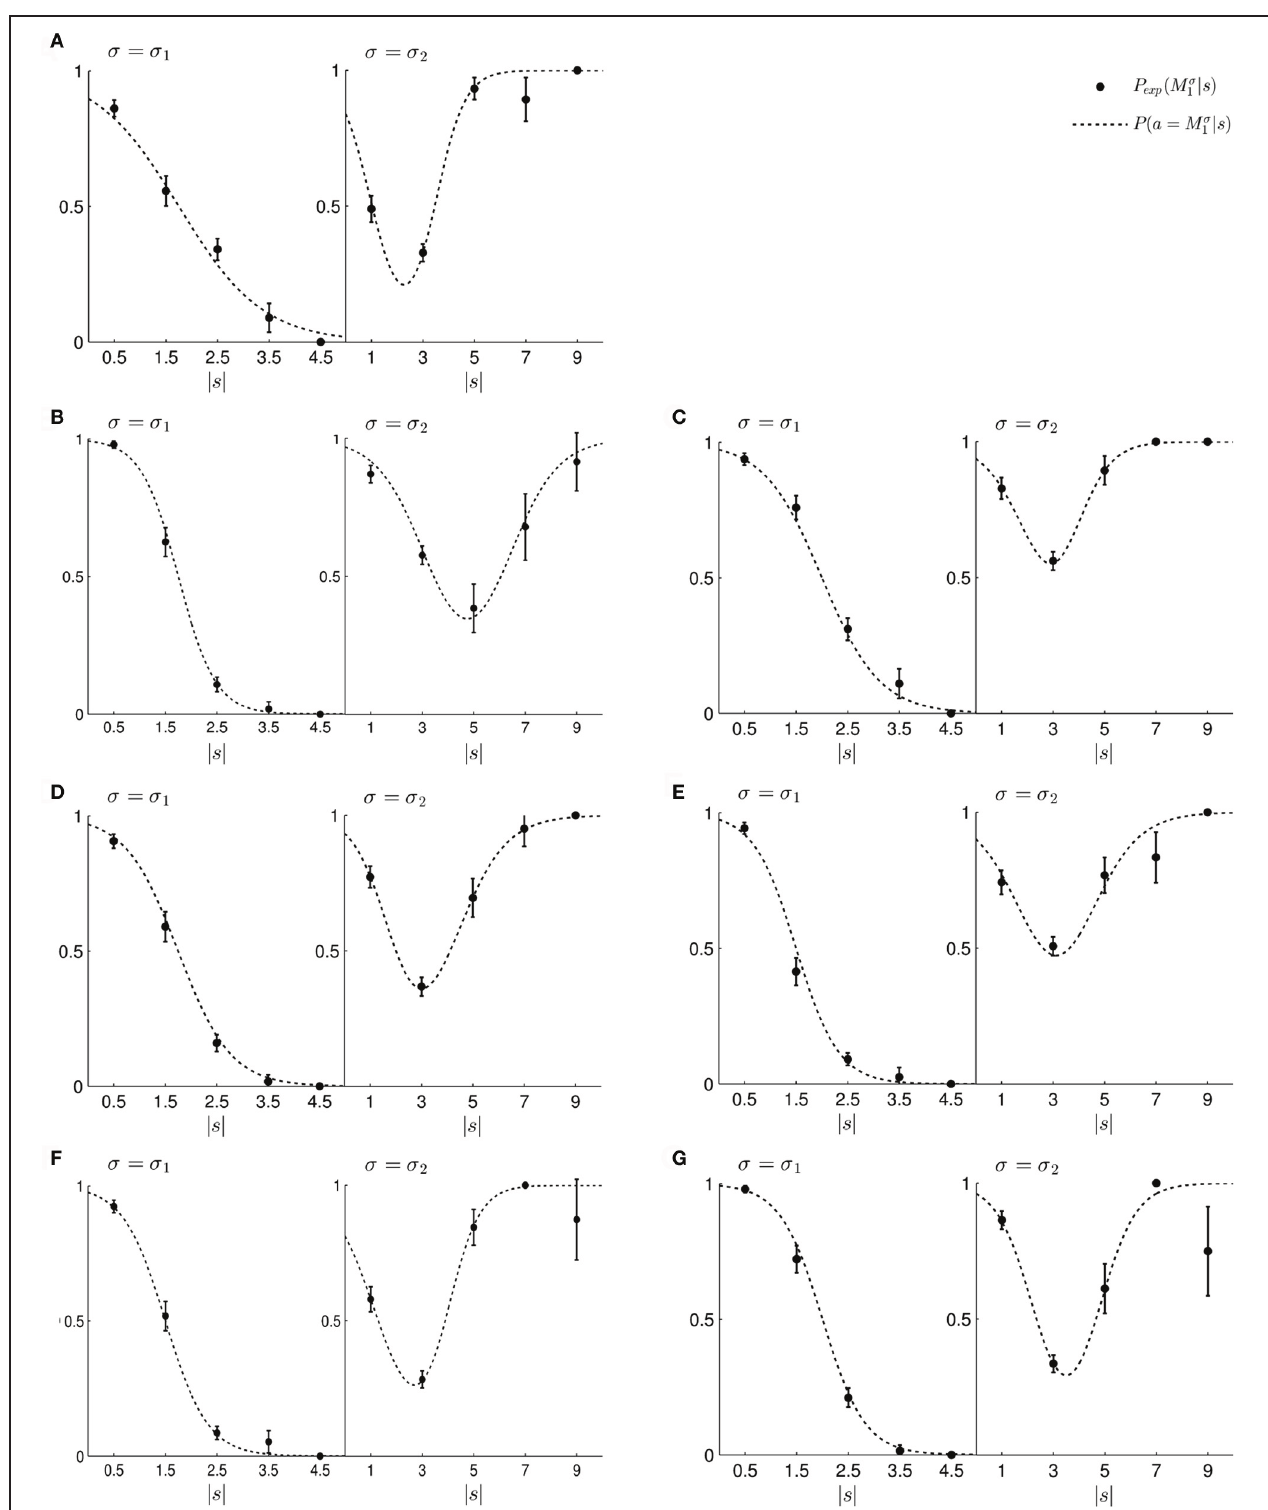
the subject’s mean choice probability P ( M σ 1 ), given a particular shift s along with standard deviation error bars. The choice probabilities for negative shifts have been mapped to the corresponding positive shift. The dotted line shows the fitted response curve that lies closest to the observed choice